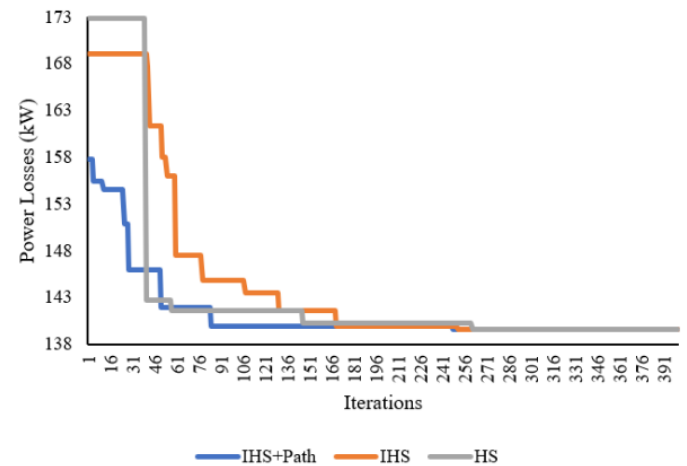
Figure 6. Convergence of the algorithms implemented for the 33-bus test system.